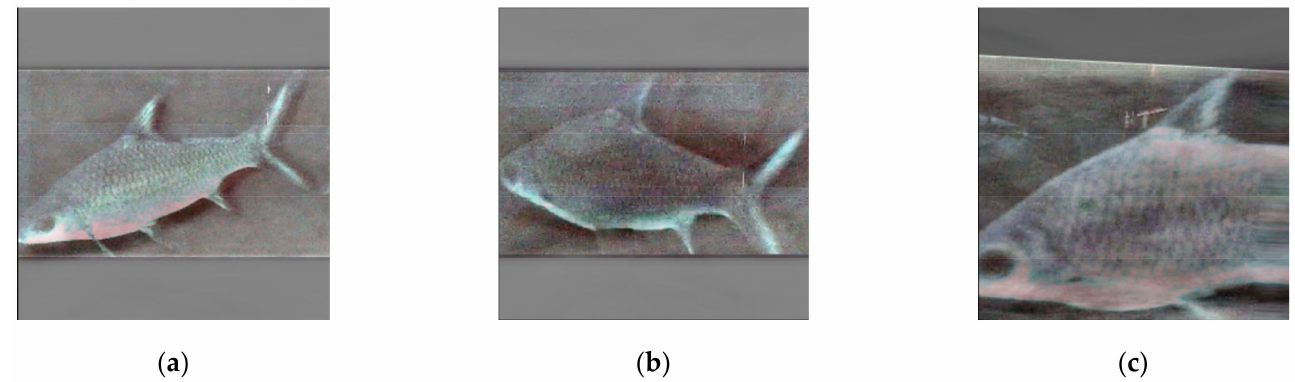
Figure 5. The image differences from various random samples: ( a ) difference from the test set, ( b ) difference from the “unseen” samples, and ( c ) difference from the “unseen” samples